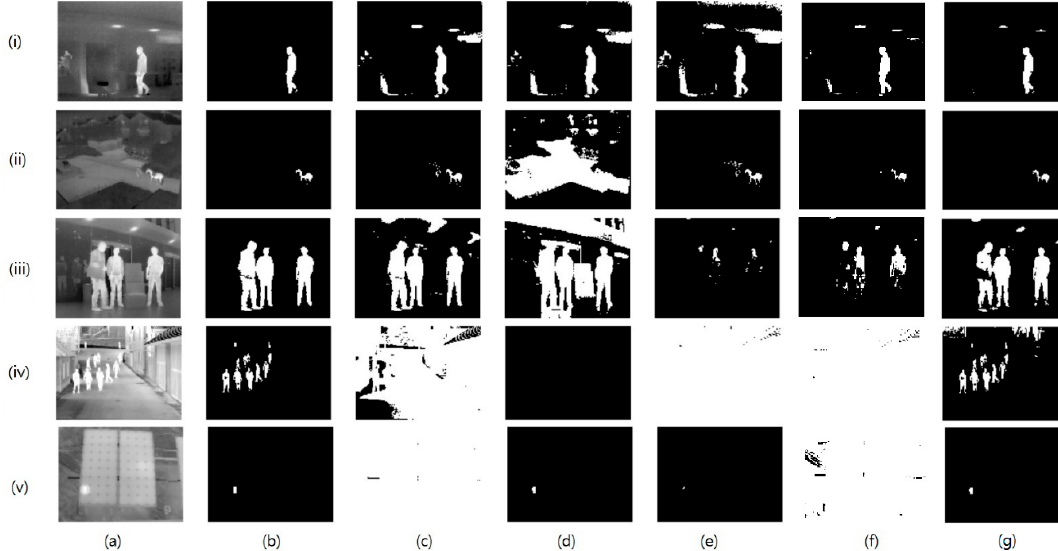
Figure 5. Comparison results of the five methods for images ( i – v ): ( a ) original image; ( b ) ground truth image; thresholding results: ( c ) Yen method; ( d ) Soundrapandiyan et al.; ( e ) Milad et al.; ( f ) Tao et al.; and ( g ) the proposed method.